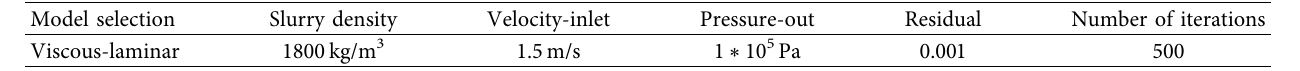
Figure 9: Pipeline model. Table 6: Numerical simulation solution settings.